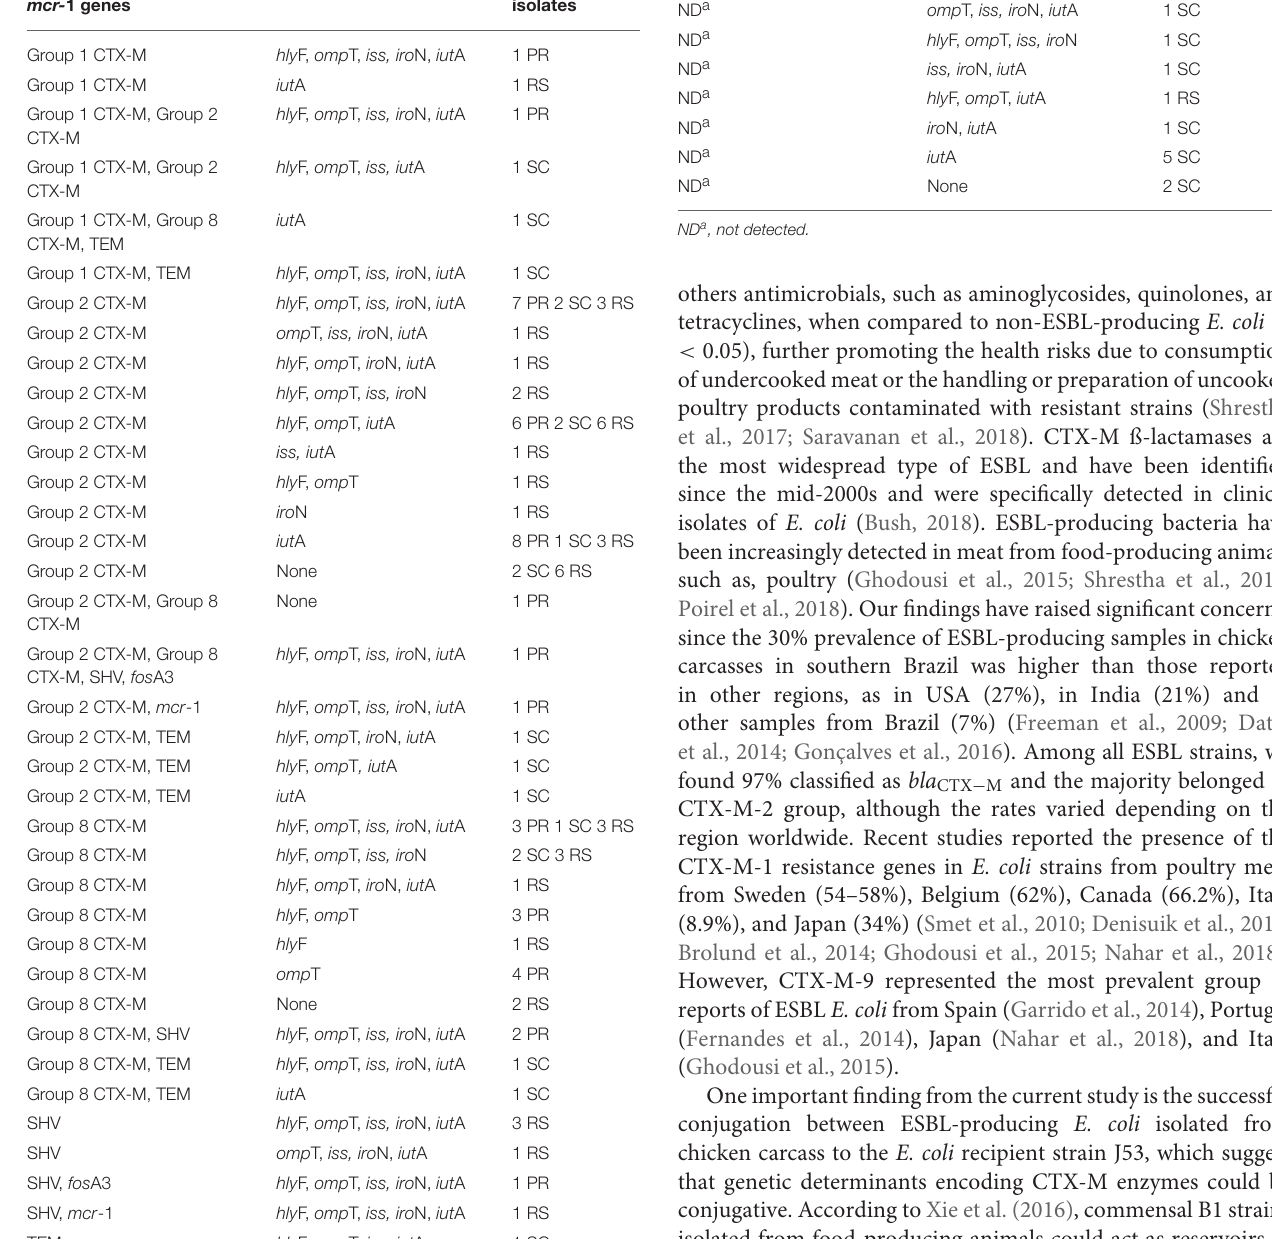
TABLE 1 | Distribution of resistance and virulence genes among 119 ESBL-producing E. coli strains isolated from chicken carcasses commercialized in Brazil. β -lactamases, fos A3, mcr- 1